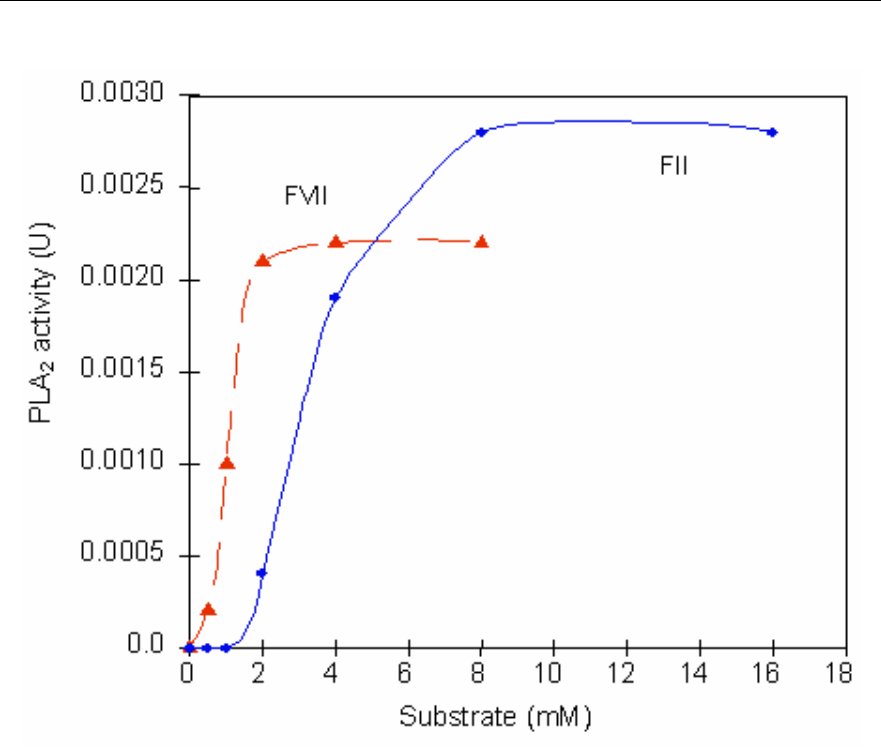
Figure 5. Effect of the substrate concentration in the reaction velocity for the two PLA isolated from B. asper